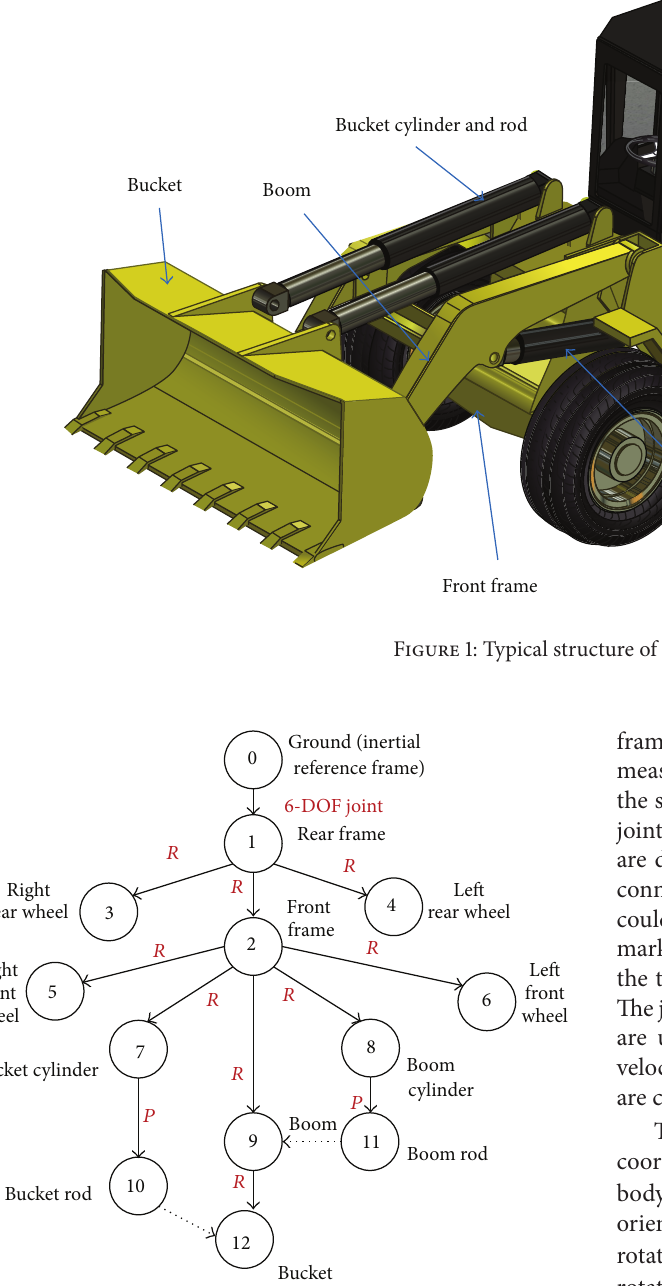
Figure 2: Kinematic tree of the wheel loader